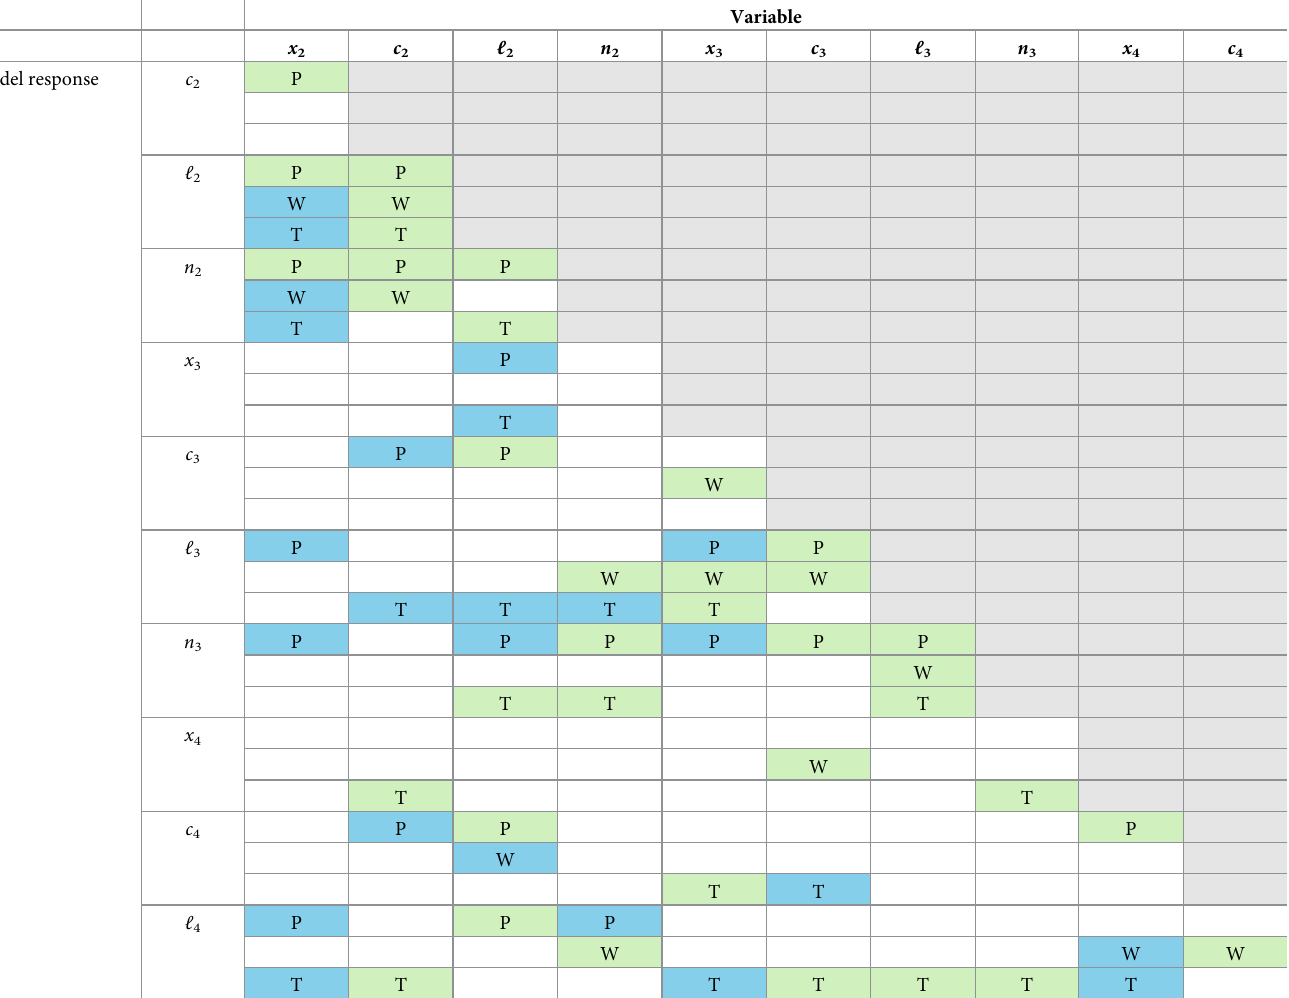
Table 4. Results of the stepwise model selection procedure. Letters P, W and T represent Pixie Tree, Wonder Tree and Tompa Tree, respectively. A green (blue) shaded sub-cell means that the covariate has a positive (negative) estimated coefficient in the fitted